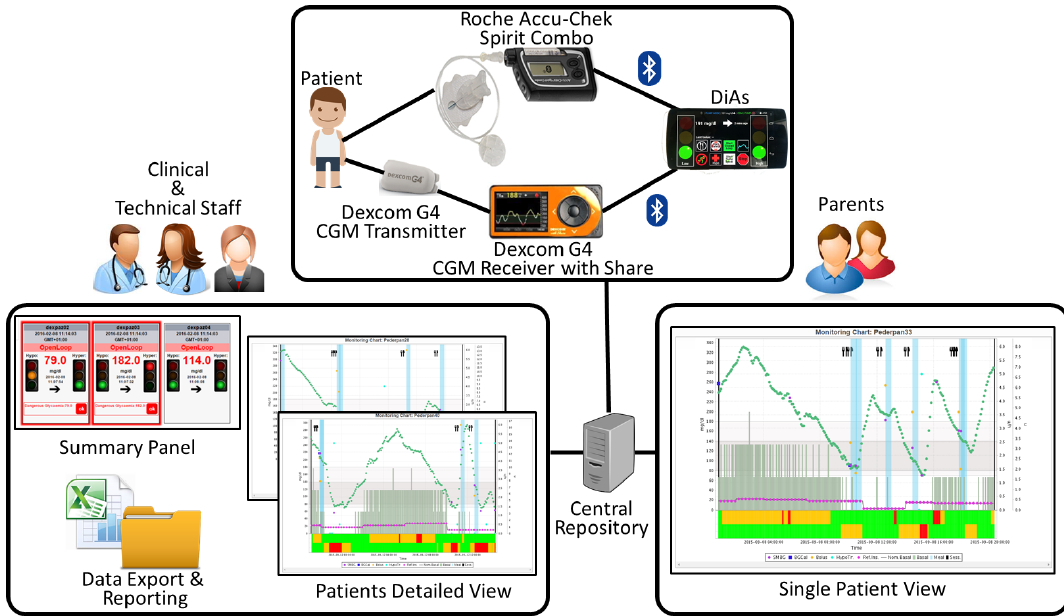
Figure 5. The remote monitoring architecture used for the adolescents camp held in